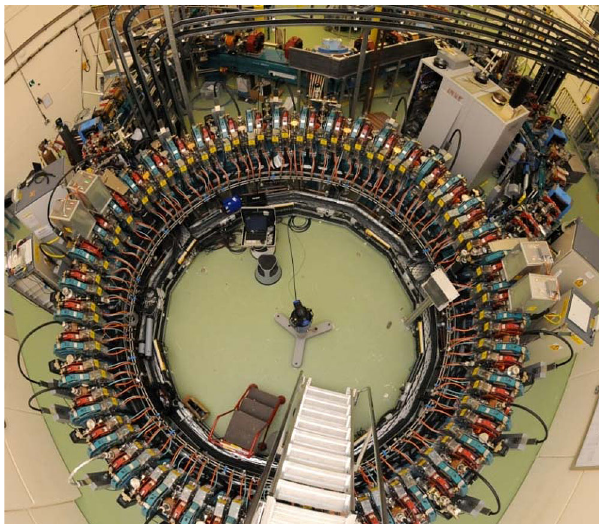
FIG. 13. The EMMA proof-of-principle accelerator at the Daresbury Laboratory.